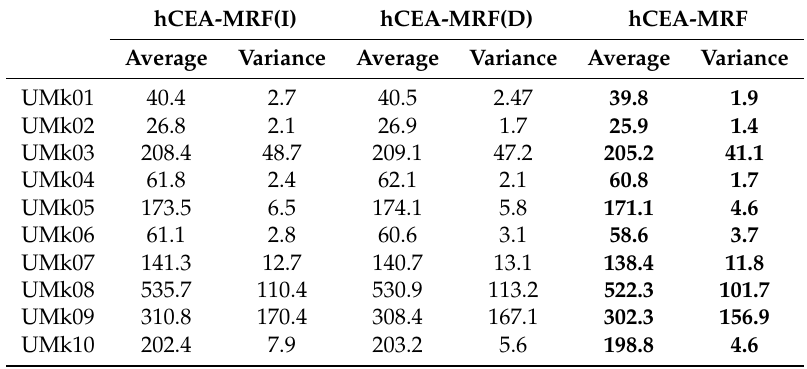
Table 7. The performance of different parameter self-adaptive strategies for the generated instances by uniform